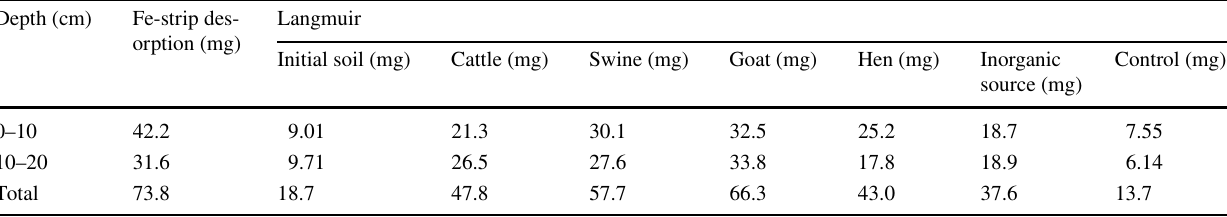
a Determination extract